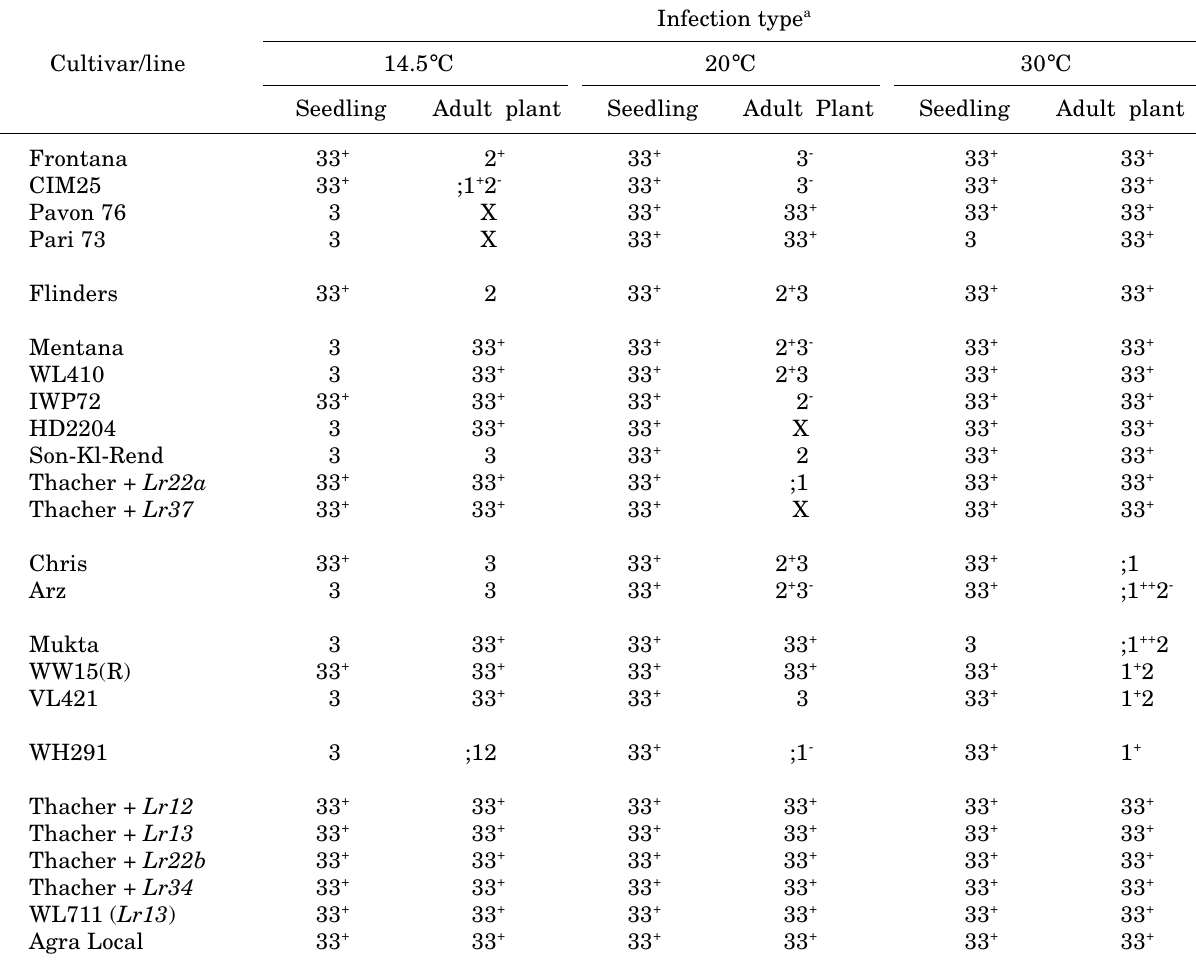
Table 1. Seedling and adult plant infection types of wheat cultivars and Thatcher near-isogenic lines when infected with race 77-5 at three temperatures. Cultivars/lines are grouped following the temperature at which adult plant resistance was